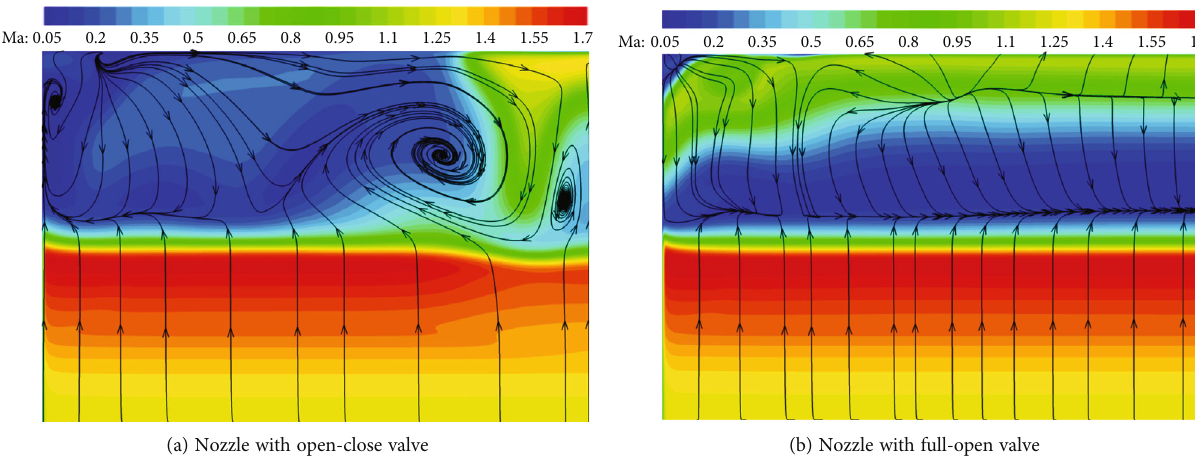
Figure 11: Vortex structure of monitoring surface a (throat of the tail nozzle).